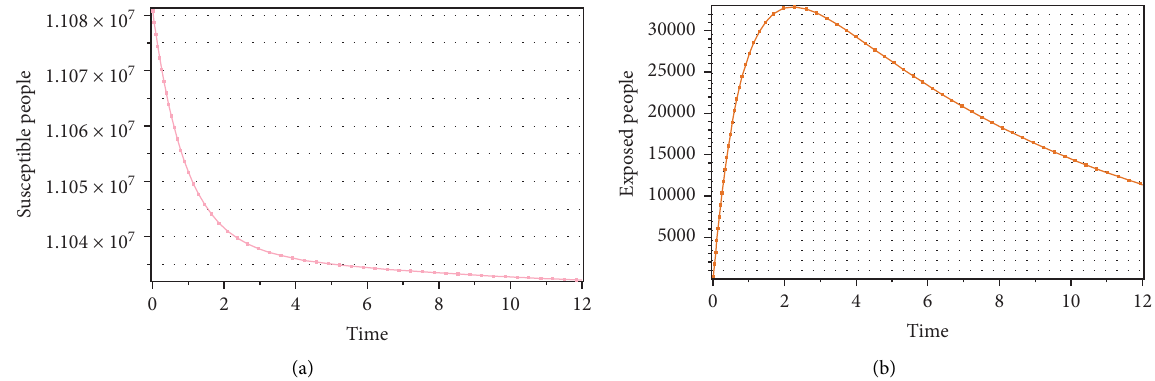
Figure 4: Diagram showing the (a) susceptible and (b) exposed people in Saudi Arabia prediction based on the SEIR model.